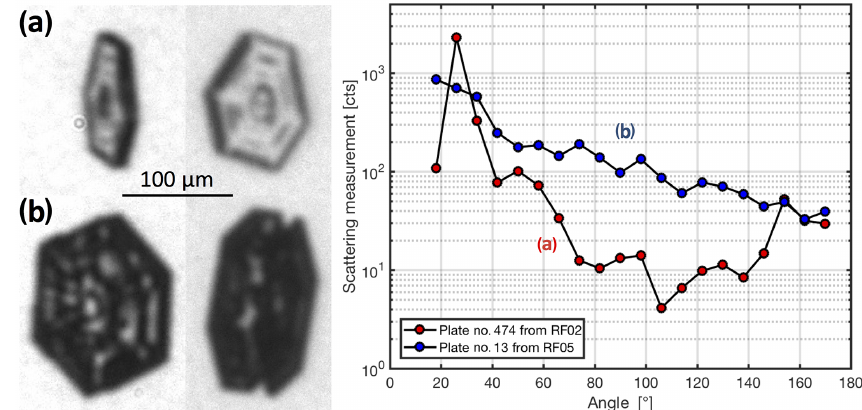
Figure 13. Stereo images of two plate-like crystals captured during the ARISTO2017 project (left). Maximum crystal dimensions are 132 and 167µm for crystal (a) and (b), respectively. Correlated angular scattering functions measured for the two crystals are shown (right). Note the 26 and 154 ◦ local maxima in the case of the more pristine crystal